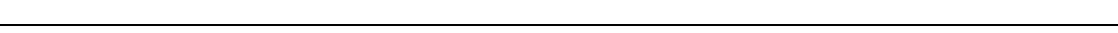
Fig. 6 Small-molecule agonists of TFEB promote lipid metabolism and extend lifespan in vivo. a Bright- fi eld images showing oil red O (ORO)-stained HepG2 cells treated with 1 mM oleic acid (OA) in combination with 370 nM DG, 3.3 μ M AD, and IKA. The graph was obtained by absorbance reading of ORO using plate reader (bars represent mean ± s.d. * p < 0.05, ** p < 0.01, *** p < 0.001 by two-way ANOVA). Scale bar, 50 μ m. b Food uptake (open symbols and right y -axis) and body weight change (solid symbols and left y -axis) of mice fed with regular diet (RD), high-fat diet with oral injection of DG solvent (HFD-oral ctrl) and HFD with DG oral injection (HFD-DG) three times a week starting from Day 35 as indicated by the arrows (bars represent mean ± s.d. * p < 0.05, ** p < 0.01, *** p < 0.001, **** p < 0.0001, HFD-DG compared with HFD-oral ctrl group by using two-way ANOVA). c Whole-body composition analysis (EchoMRI) of the same mice as in b and Supplementary Fig. 6 c , d after 3 weeks of treatment with compounds or their corresponding controls. d – g Total serum triglyceride, cholesterol, glucose, and insulin levels in compound-treated mice or their corresponding control mice after 3 weeks of treatment with compounds or their corresponding controls. h Glucose levels at indicated time points after glucose challenge (left panels) and insulin challenge (right panels). In b – h , n = 3 – 5 mice per group, bars represent mean ± s.d. * p < 0.05, ** p < 0.01, *** p < 0.001, **** p < 0.0001 by two-way ANOVA. i Hematoxylin and eosin (H&E) staining, ORO staining and immunohistochemistry staining against p62 of liver sections isolated from mice after 3 weeks of treatment with or without compounds. HFD-i.v. ctrl, mice injected with empty PEG-PLA nanoparticles. Scale bars, 100 μ m. j Representative images of HLH-30::GFP nuclear translocation in dal-1(dt2300); sqIs19 [hlh-30p::hlh-30::GFP] C . elegans treated with 5 μ M IKA or DMSO. Insets show enlarged images from the white boxes in the main images. Yellow arrows denote nuclear localized HLH30::GFP. Scale bar, 100 μ m and 10 μ m (insets). k The Kaplan – Meier curves of dal-1(2300);fem-1(hc17ts) mutant C . elegans treated with 5 μ M IKA or DMSO ( n = 2 independent experiments, **** p < 0.0001 by log-rank